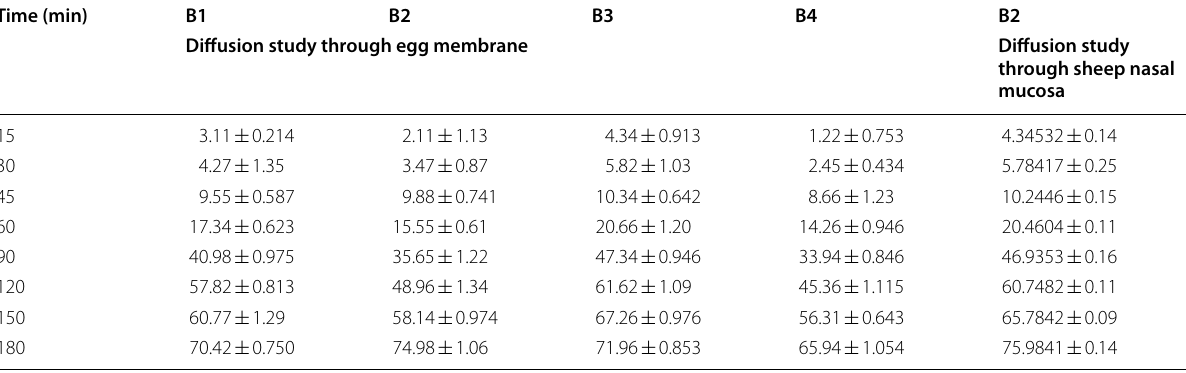
Table 6 % CDR values after diffusion profile studies Time (min) B1 B2 B3 Diffusion study through egg